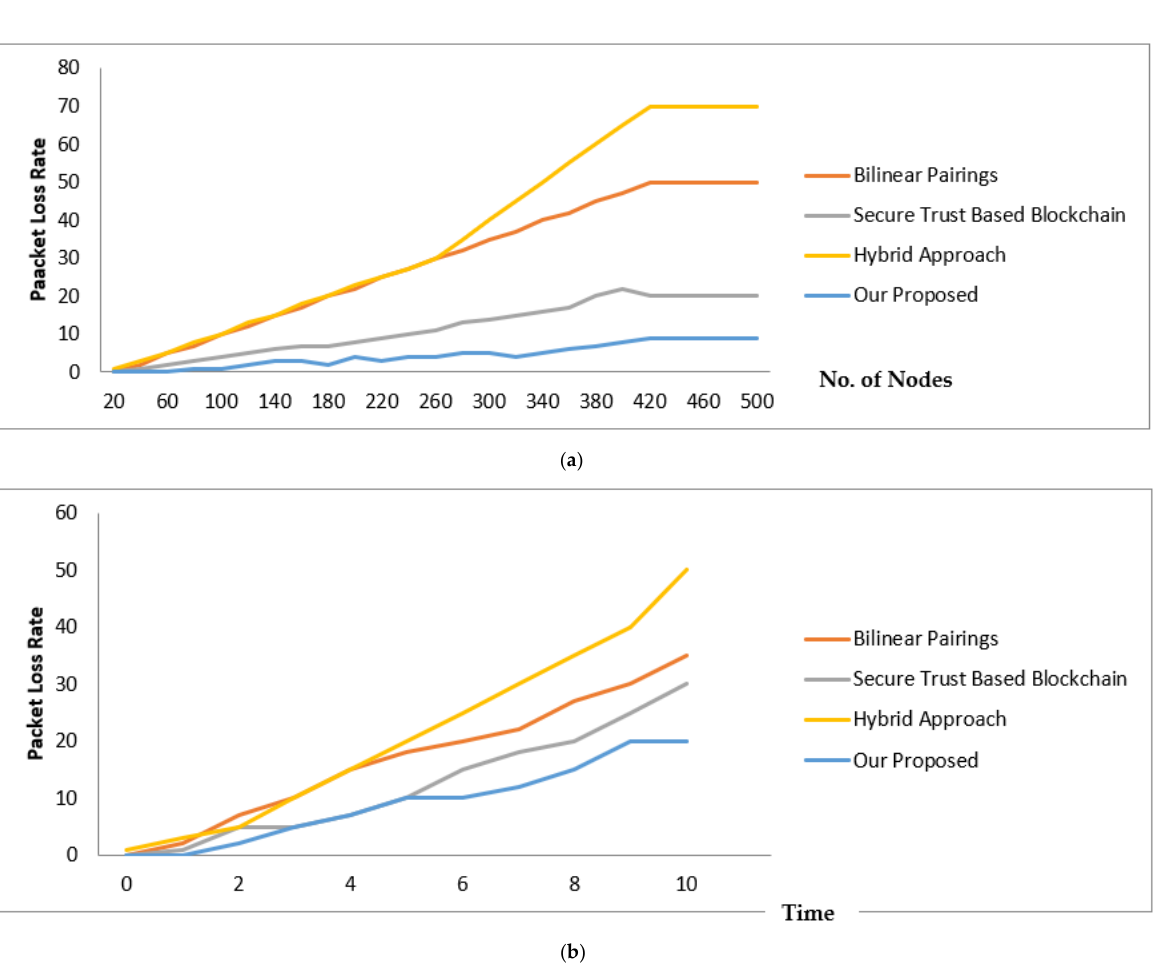
Figure 6. ( a ): Average Packet Loss Rate with DDoS Attack w.r.t No. of Nodes; ( b ): Average Packet Loss Rate with DDoS Attack w.r.t Time.